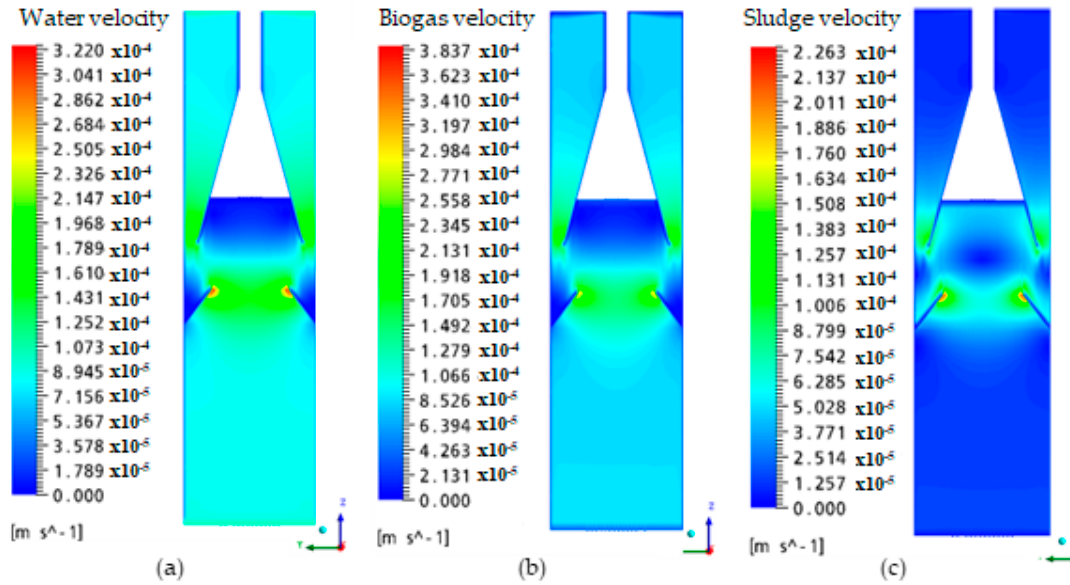
Figure 4. Velocity field in the UASB reactor, with deflector inclination upwards, for phases: ( a ) water, ( b ) biogas, and ( c ) sludge.